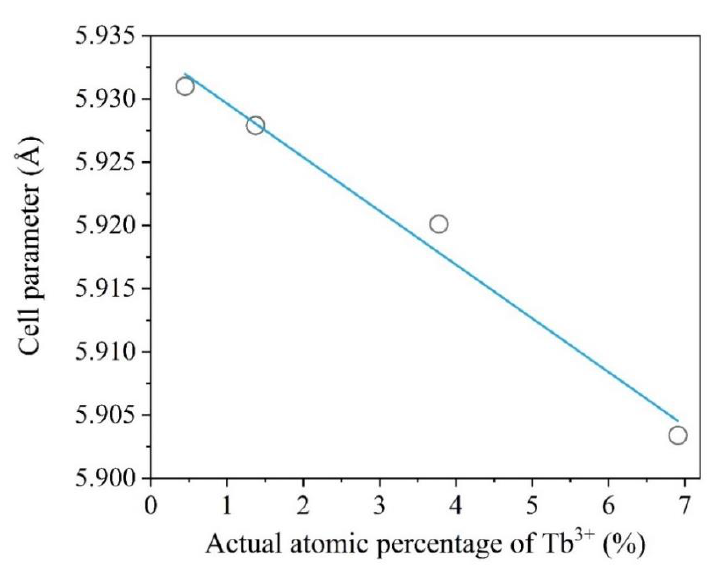
Figure 2. Correlation between the actual percentage of doping Tb 3+ ions and the refined lattice pa- rameter.